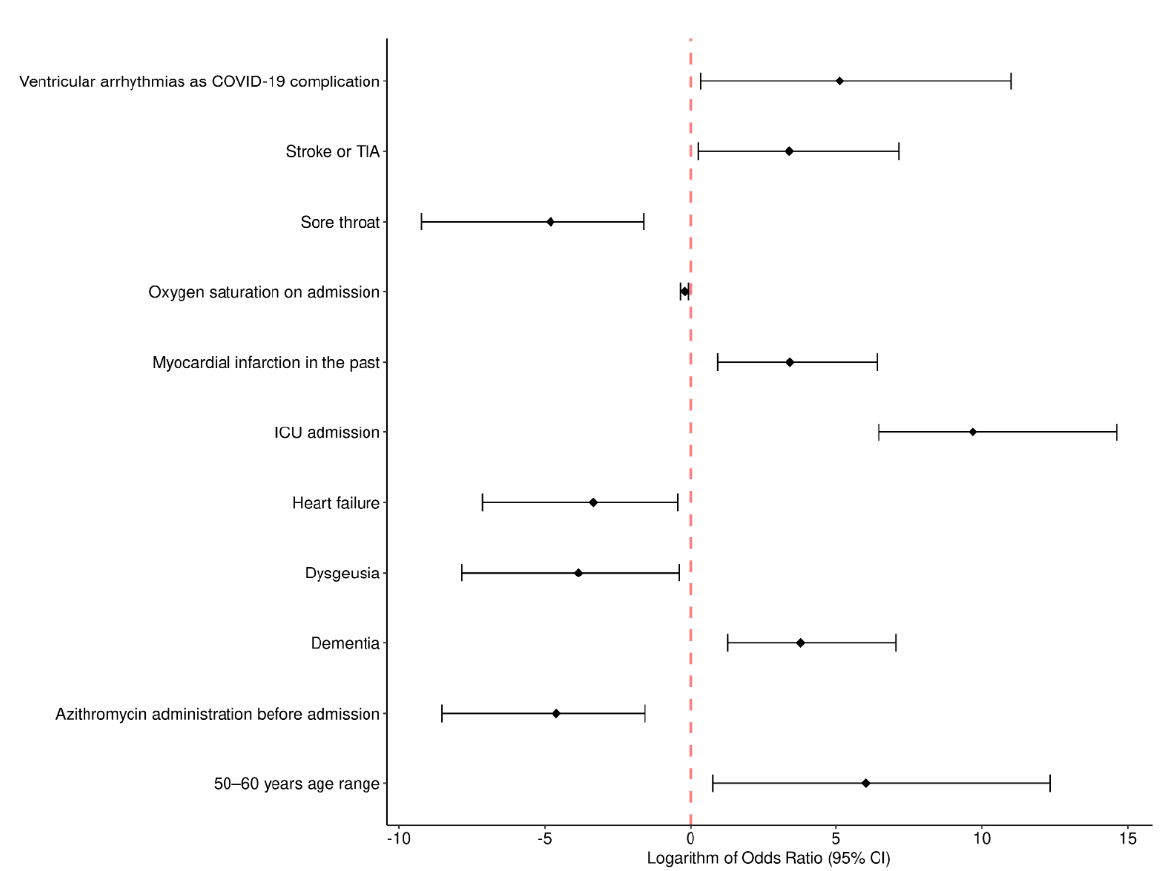
Figure 2. Multivariate logistic regression model analysis of the factors independently associated with death during the first COVID-19 wave in the Hospital for Infectious Diseases in Warsaw (Poland).